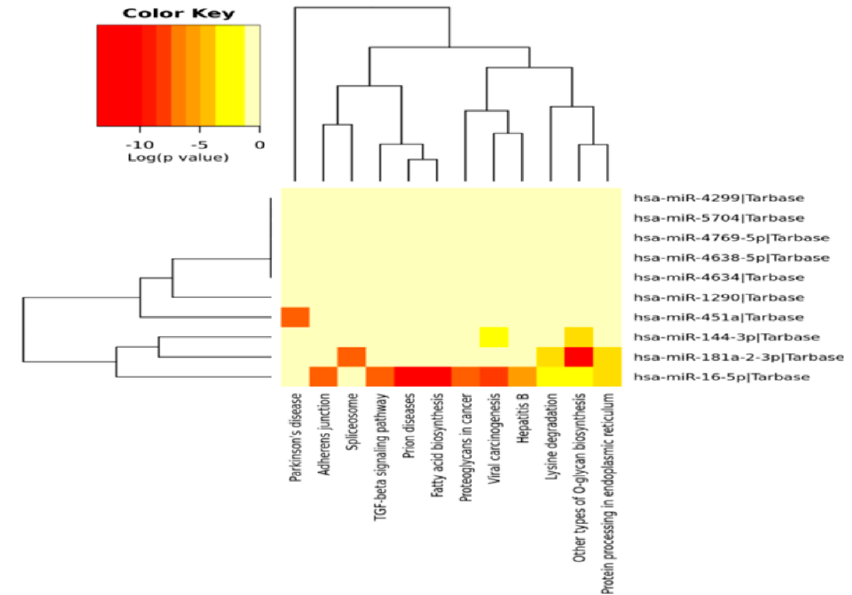
Figure 5. Heatmap of the 10 DEMs (3 upregulated and 7 downregulated miRNAs) showing the top 10 enriched functional pathways ( x -axis represents the name of the pathways and y -axis represents the